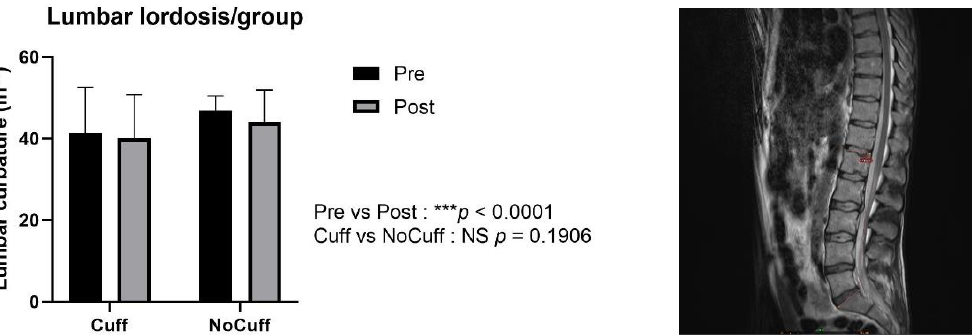
Figure 2. Magnetic resonance imaging (MRI) T2 sagittal sequence centered in the median plane. Lumbar lordosis (vertebral endplates L 1 -S 1 in red line) decreased pre- vs post ( t -test *** p < 0.0001; 95% CI from 39.50 to 48.45° in pre to 37.05 to 46.80° in post) with no effect of the countermeasure ( p < 0.1906).